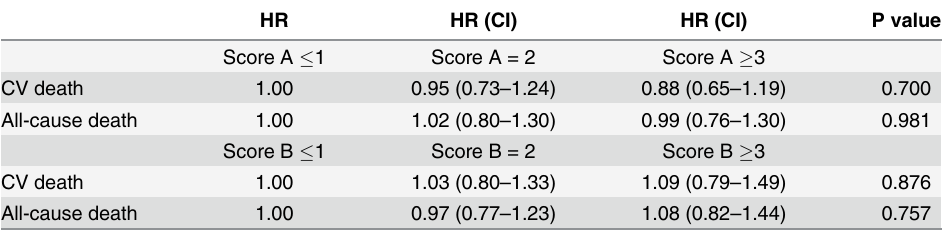
Table 4. Risk of cardiovascular (CV) death and all-cause death with genetic scores A and B in patients treated with angiotensin-converting enzyme inhibitors after 5 years of